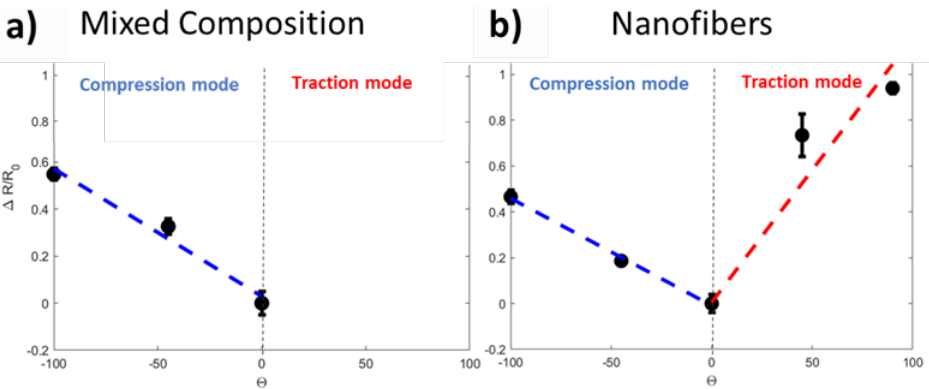
Figure 5. ( a ) resistance variation when bending the sample for the MC structuration and ( b ) resistance variation when bending the sample for the NFs.